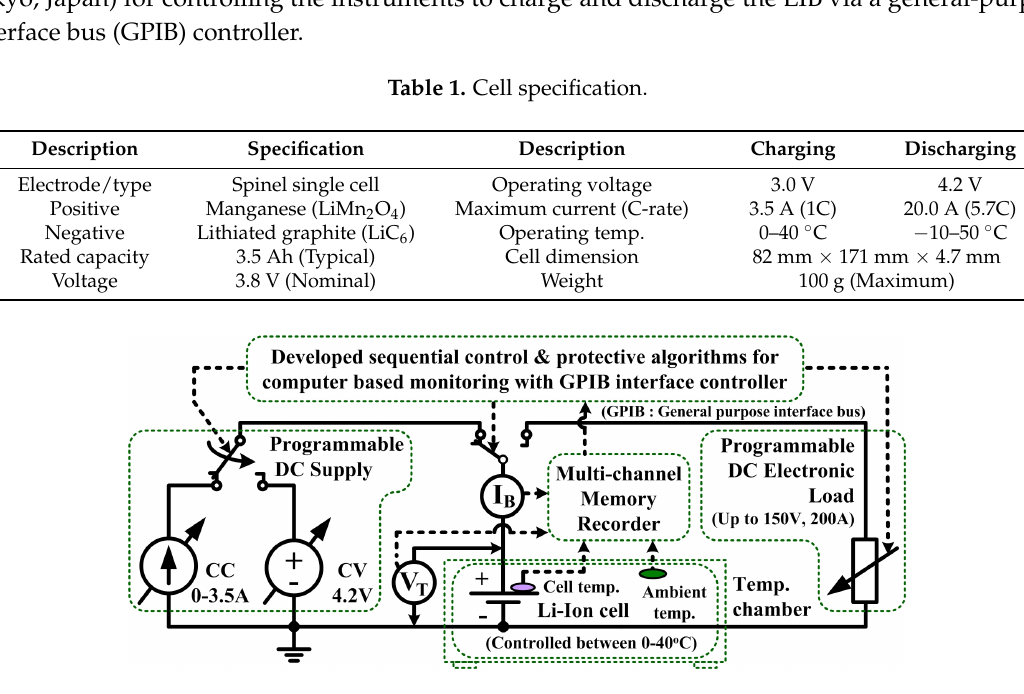
Figure 3. A developed LIB test system with computer based control for OCV characterization.